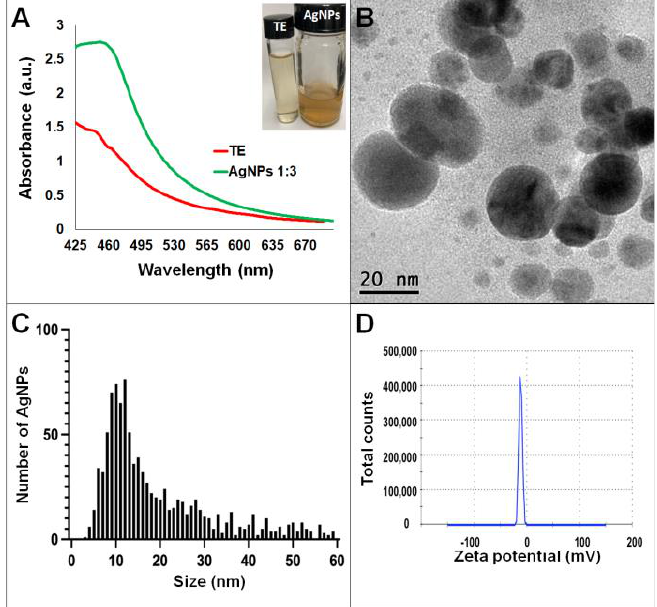
Figure 2. Silver nanoparticles obtained with the optimized protocol using the extract of T. harzianum ( A ) UV-Vis analysis of AgNPs-TE after 72 h of reaction, ( B ) TEM micrograph showing the morphology of NPs, ( C ) size distribution histogram of AgNPs, ( D ) Zeta potential. Inset in ( A ) shows the fungal extract and synthesized NPs. TE = Trichoderma extract.